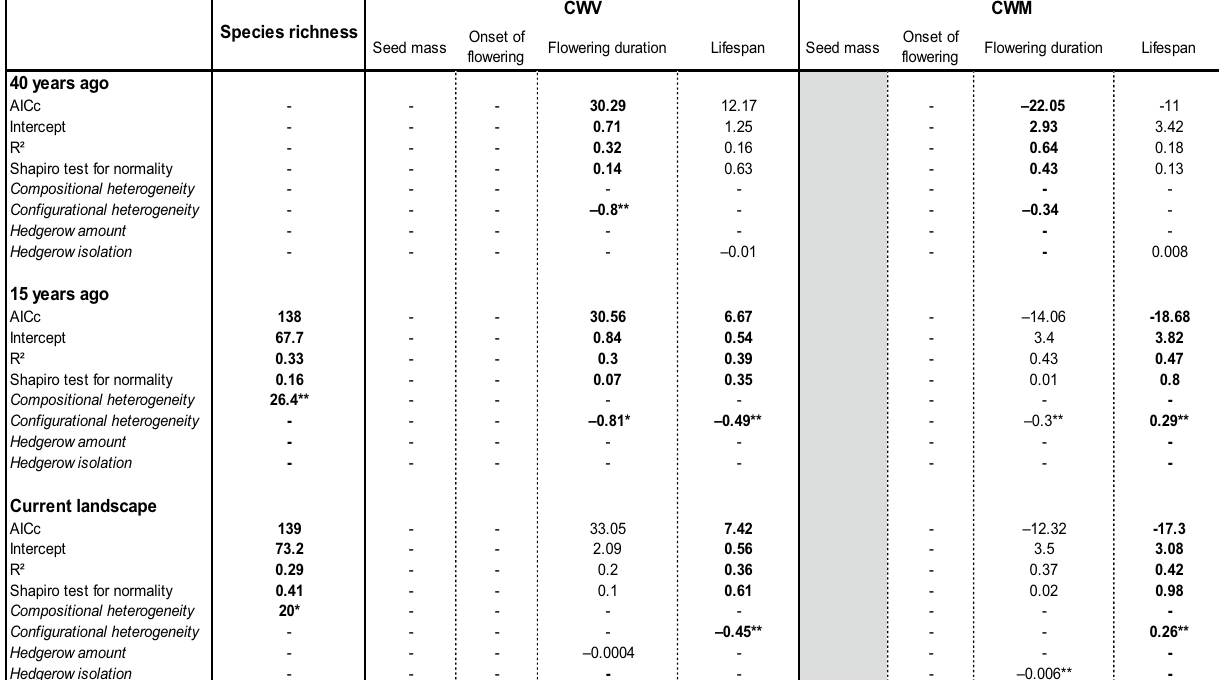
Configurational